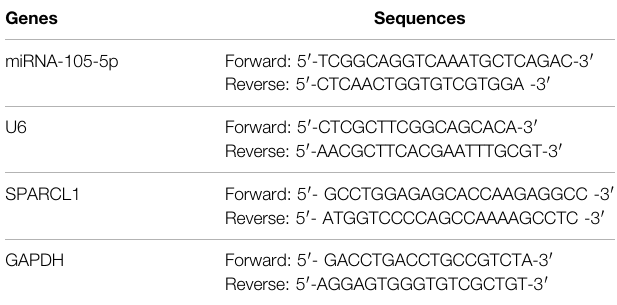
TABLE 1 | Primer sequences for